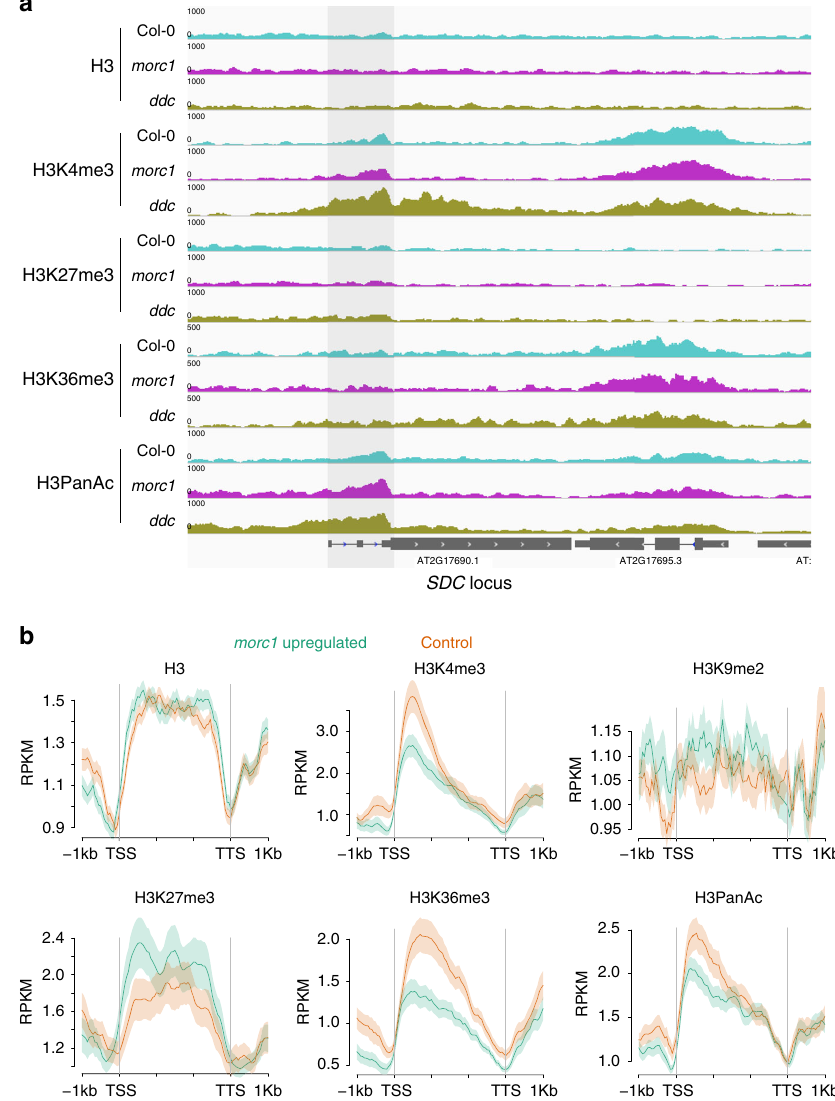
Fig. 4 Characterization of the epigenetic features at SDC and other morc1 upregulated loci. a Screen shot showing the distribution of (from top to bottom) H3, H3K4me3, H3K27me3, H3K36me3, and H3PanAc over the endogenous SDC locus in Col-0 (top track), morc1 (middle track), and ddc (bottom track). Shaded area indicates the region downstream of SDC TSS. b Average distribution of histone modi fi cations over morc1 upregulated genes (green) and corresponding controls of similar expression levels (purple). Shaded area represents the standard error (SEM) centered on mean value (dark solid lines). n = 3 biologically independent